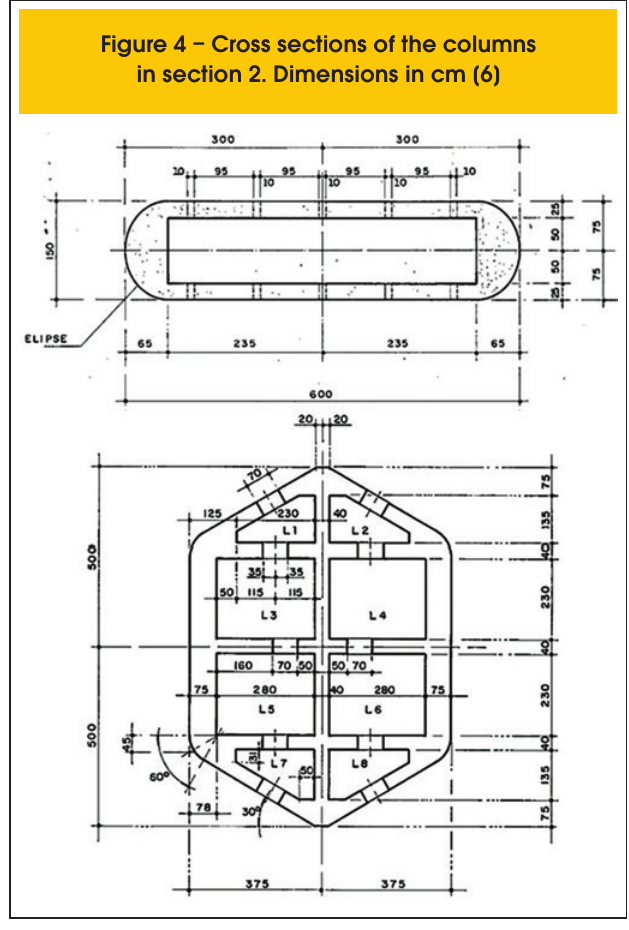
Figure 4 – Cross sections of the columns in section 2. Dimensions in cm